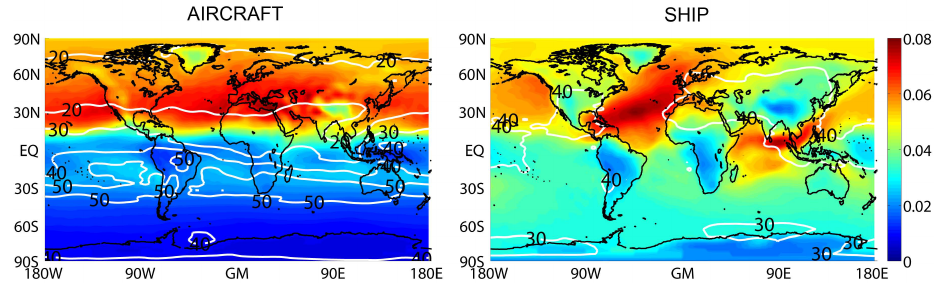
Fig. 5. Yearly mean perturbations of the ozone column ( 1 DU, up to 40hPa) due to a 5% perturbation of aircraft emissions (left) and ship emissions (right) for the 2050 B1 scenario. The white contour lines show the standard deviation relative to the ensemble mean column perturbation (%), and have been smoothed to improve